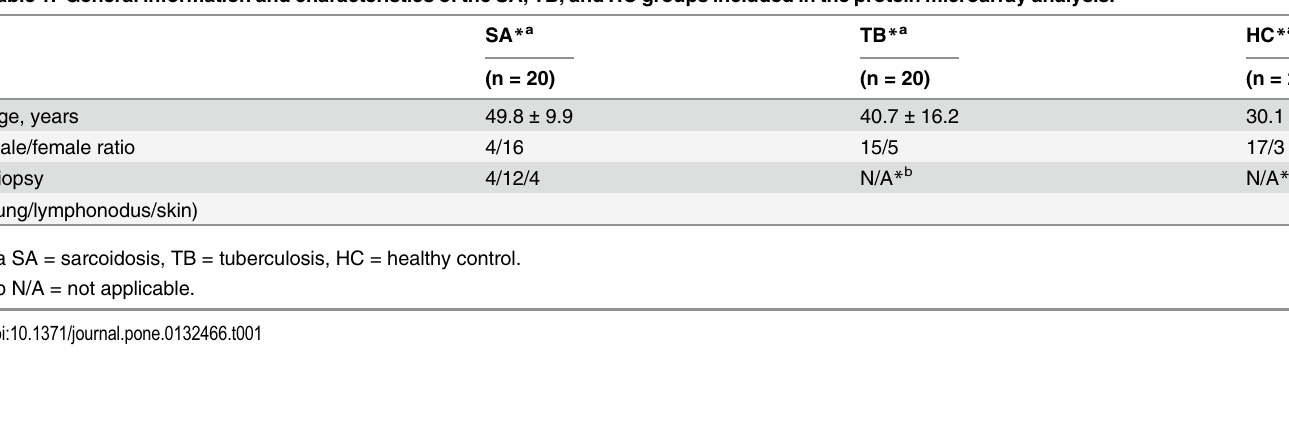
Table 1. General information and characteristics of the SA, TB, and HC groups included in the protein microarray